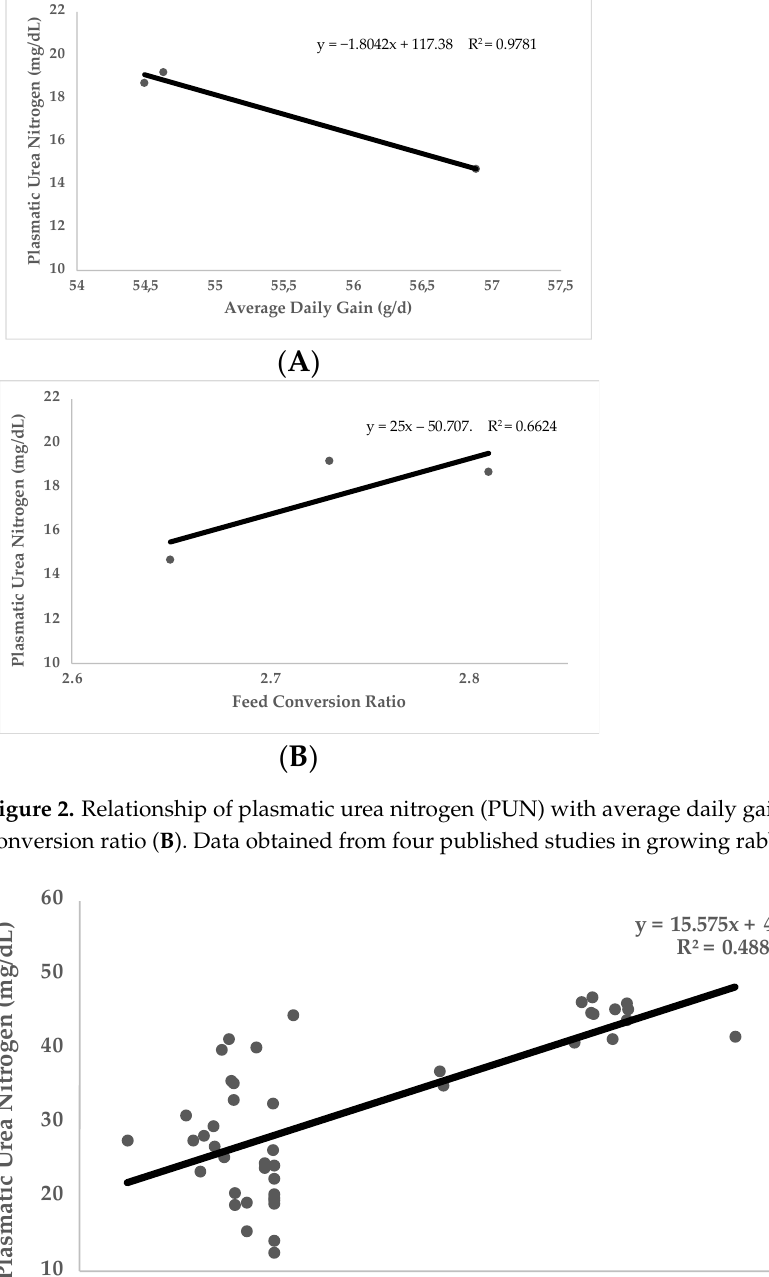
Figure 3. Relationship of plasmatic urea nitrogen (PUN) with feed conversion ratio. Data obtained from four published studies in growing pigs [65,66,73,75,76,78].